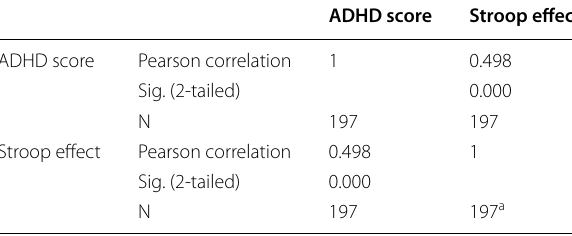
a Correlation is significant at the 0.01 level (2-tailed)